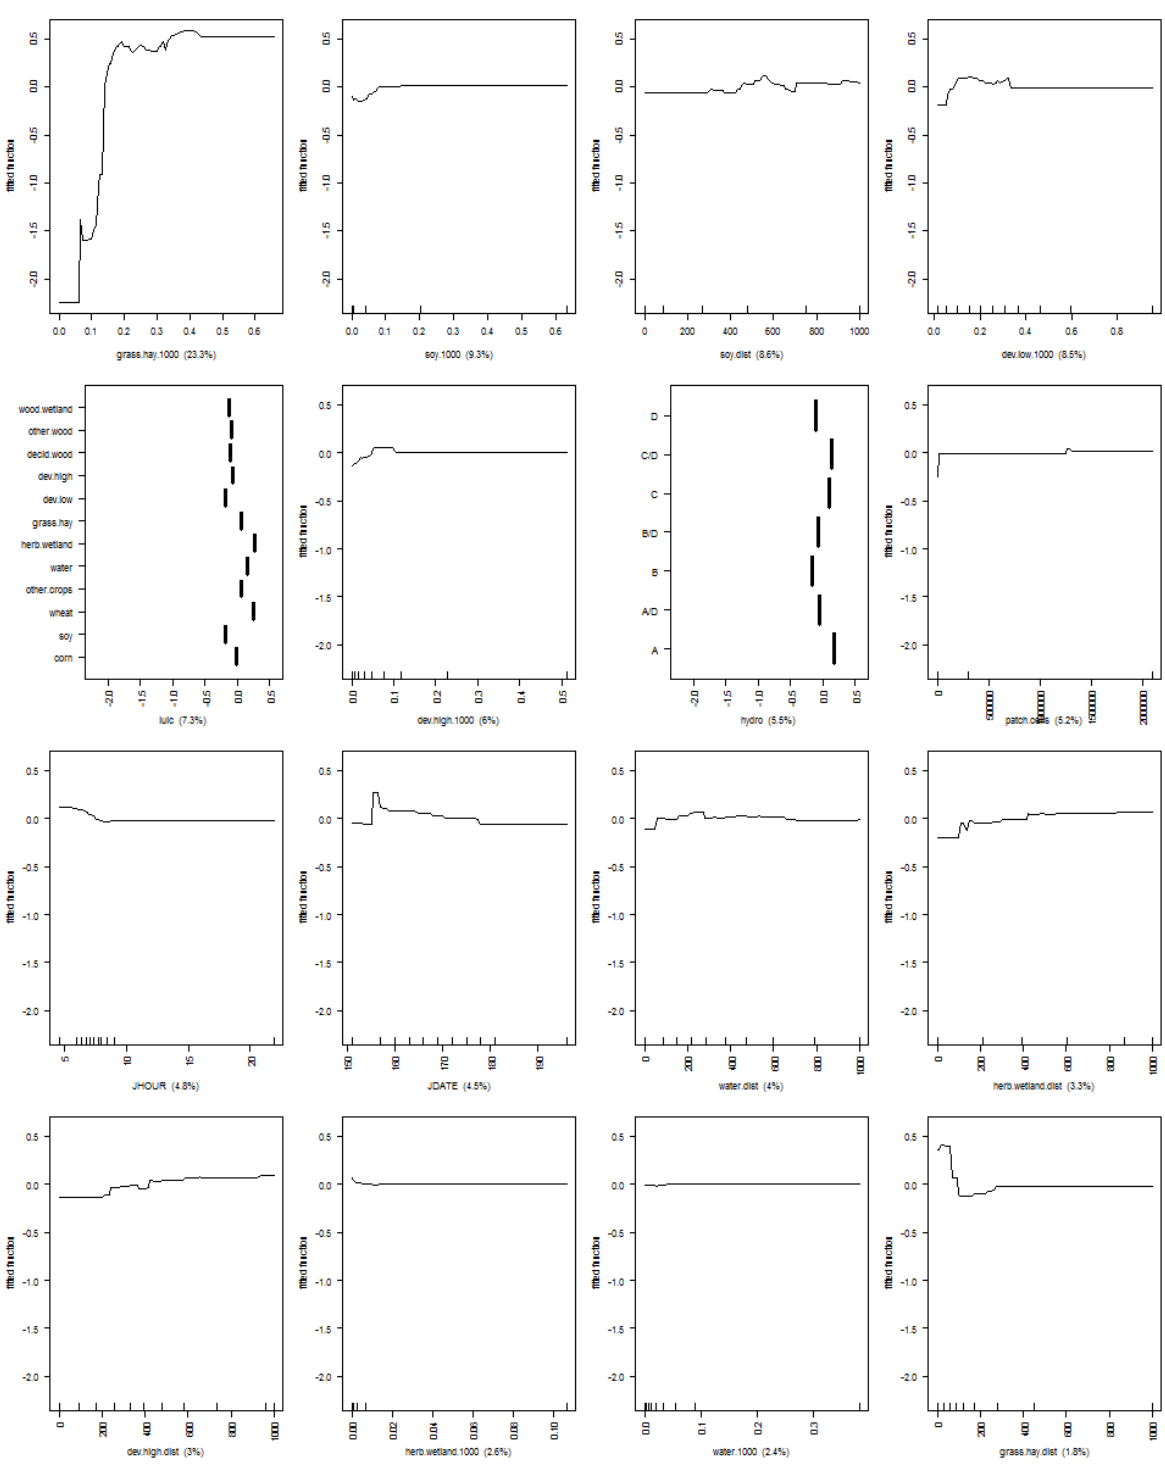
Figure A1.4c. Response curves for Grasshopper